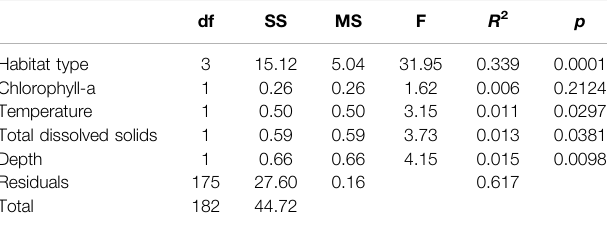
TABLE6| ANOVAtableforthepermutationalstatisticalmodelofpresence-based species composition. df